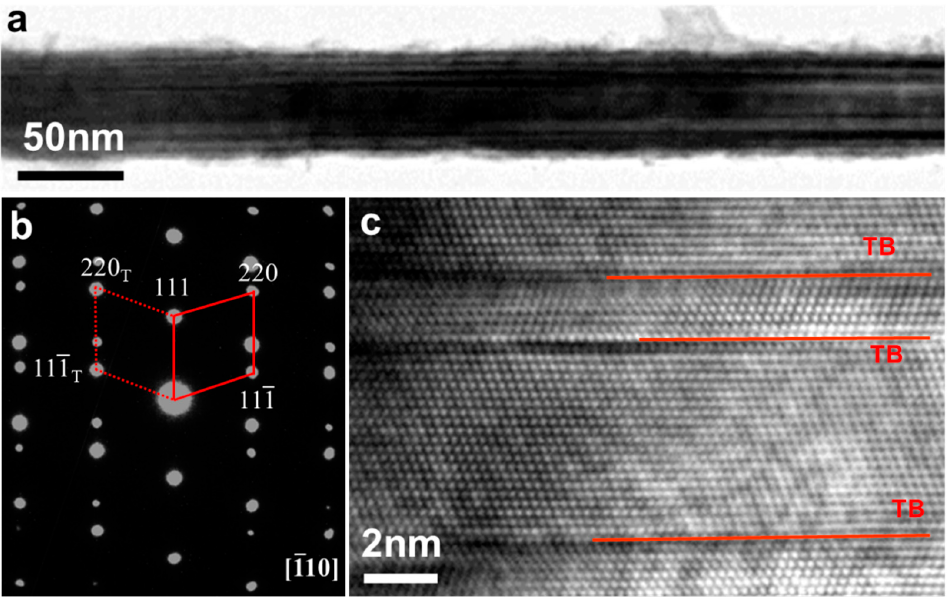
Figure 2. ( a ) TEM image showing the microstructure of twin-structured Ni NWs. ( b ) The corre- sponding selected area electron diffraction patterns captured along the [1 (cid:3364) 10] direction, indicating the presence of (111) twins in the NWs. ( c ) HTEM image revealing the growth of several twins in the Ni NWs.